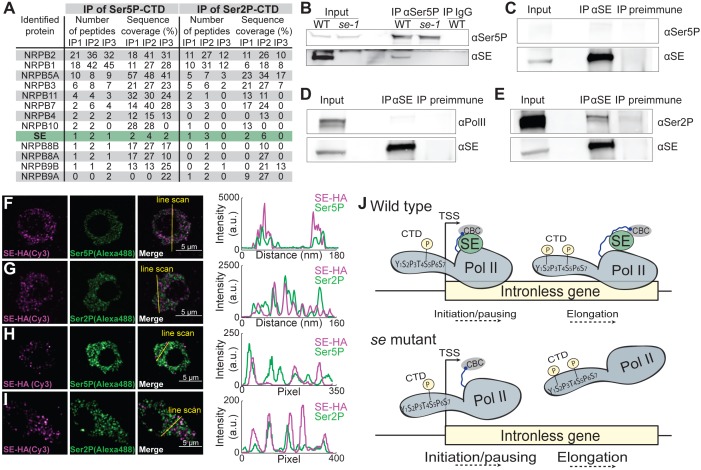
SE associates with Ser5P and Ser2P pol II complexes.(A) Summary of mass spectrometry (MS) analysis of immunoprecipitation (IP) reactions using antibodies against RNA polymerase II phosphorylated at Serine 2 (Ser2P) and Serine 5 (Ser5P) of its C-Terminal domain (CTD) from Arabidopsis lysates. Protein coverage and peptide number are represented for known RNA polymerase subunits and SE in three independent biological replicates. (B–E) Co-immunoprecipitation experiments using SE and phosphorylation-specific pol II antibodies. Western blot analysis of pol II Ser5P and IgG (as a negative control) immunoprecipitation experiments from Arabidopsis (B). Immunoprecipitation of SE from B. oleracea using a SE-specific antibody followed by detection of unphosphorylated (D), Ser5P (C) and Ser2P (E) pol II. The images are representative of at least three independent biological replicates. (F–I) Immunolocalization of pol II Ser5P, pol II Ser2P and SE-HA on a 100 nm thin thawed cryosection analyzed by super-resolution microscopy (F,G: Airyscan; H,I: Super-resolution optical fluctuation (SOFI) microscopy). Lines depicte the position for line blot analysis. (J) Proposed mechanism for the function of SE at intronless genes.